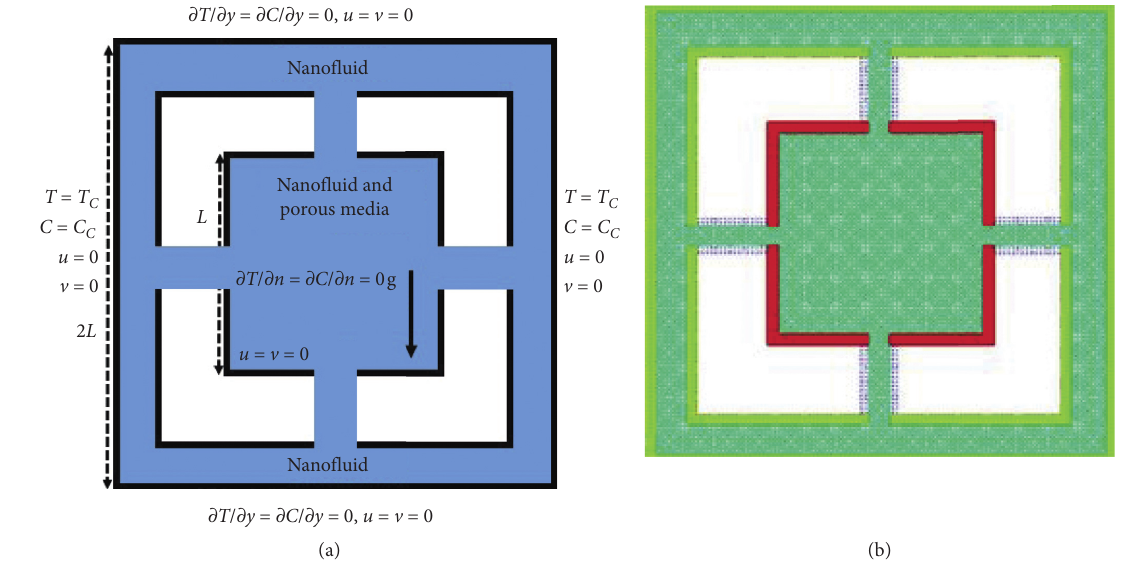
Figure 1: Initial schematic diagram and initial particle distributions. Table 1: Nanofluid thermo-physical properties at T � 310K